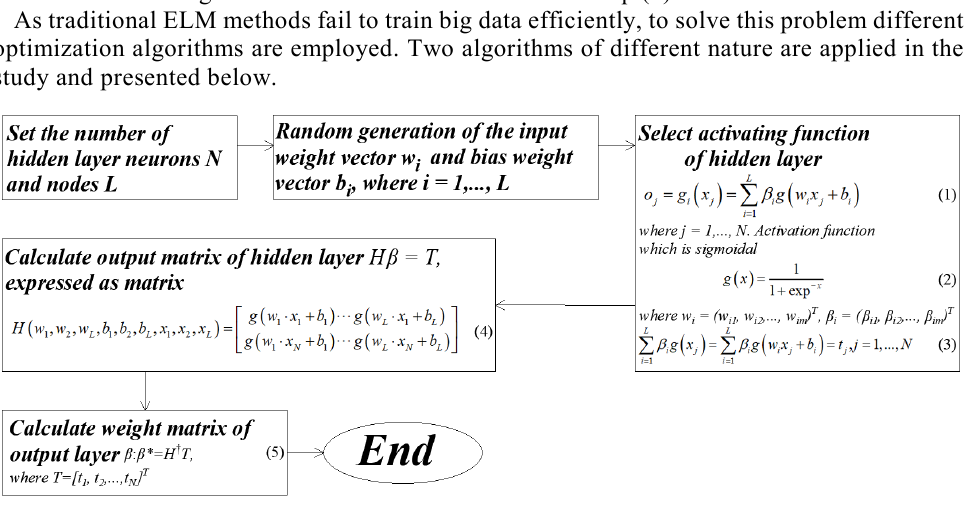
Fig. 3 Steps of the ELM learning procedure .